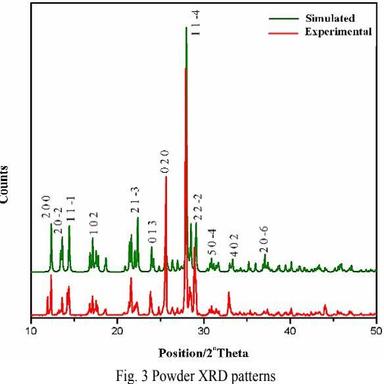
ORTEP of FHM b) Crystal packing in the unit cell